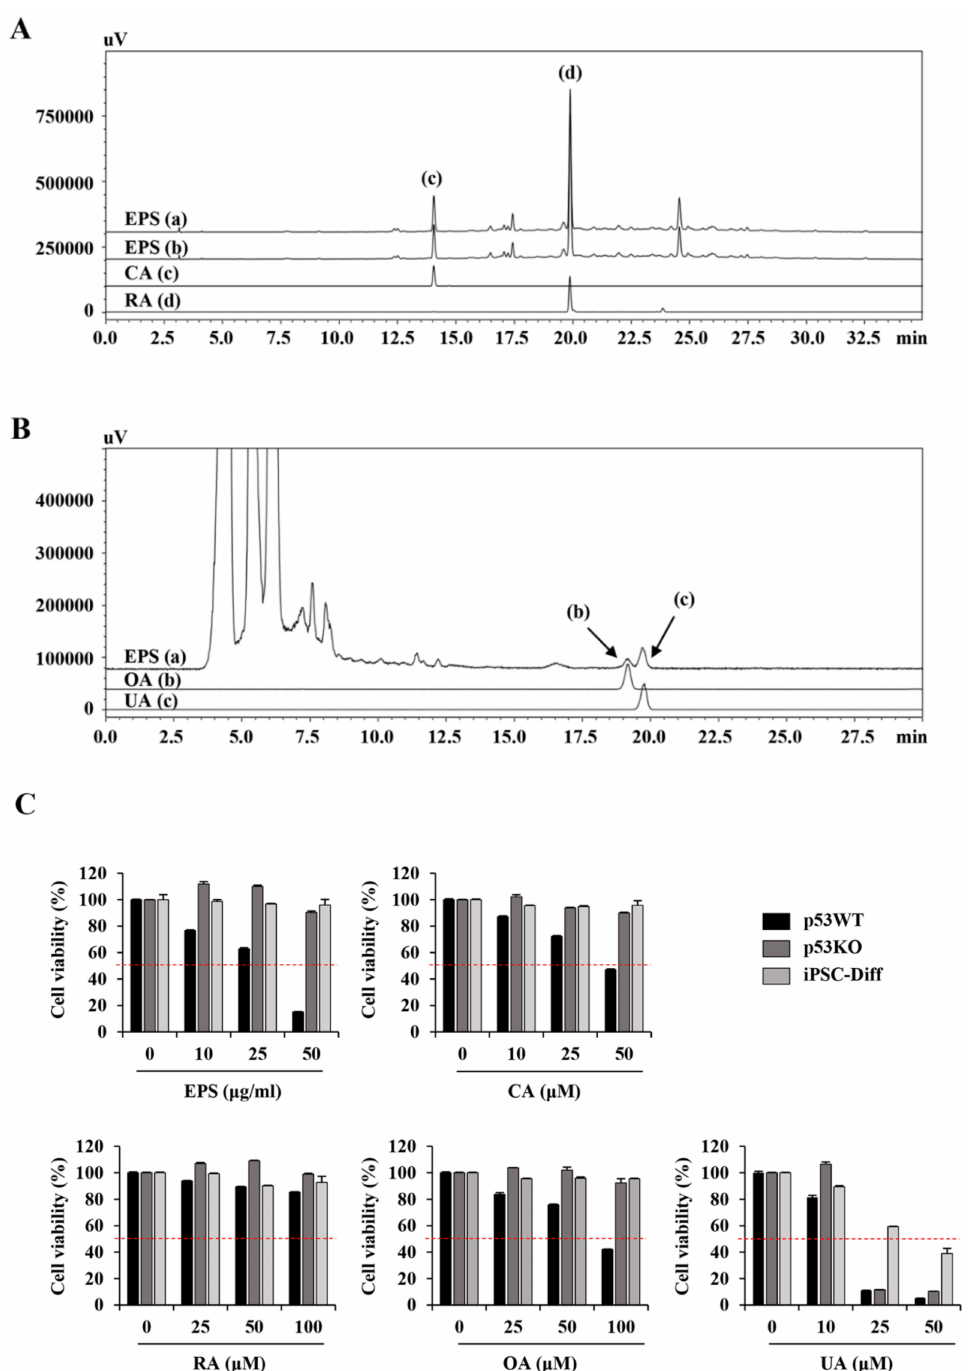
Figure 9. Chromatogram of four major standard compounds in EPS. ( A ) Using HPLC–PDA, EPS (a, 325 nm; b, 330 nm) and two phenylpropanoids, CA (c) and RA (d) were identified in EPS at 14.037 and 19.870 min, respectively. ( B ) Using HPLC–ELSD, EPS (a) and two triterpenoids, OA (b) and UA (c) were identified in EPS at 19.154 and 19.782 min, respectively. ( C ) p53WT and p53KO hiPSCs and iPSC-Di ff were treated with the indicated concentrations of EPS, CA, RA, OA, and UA for 24